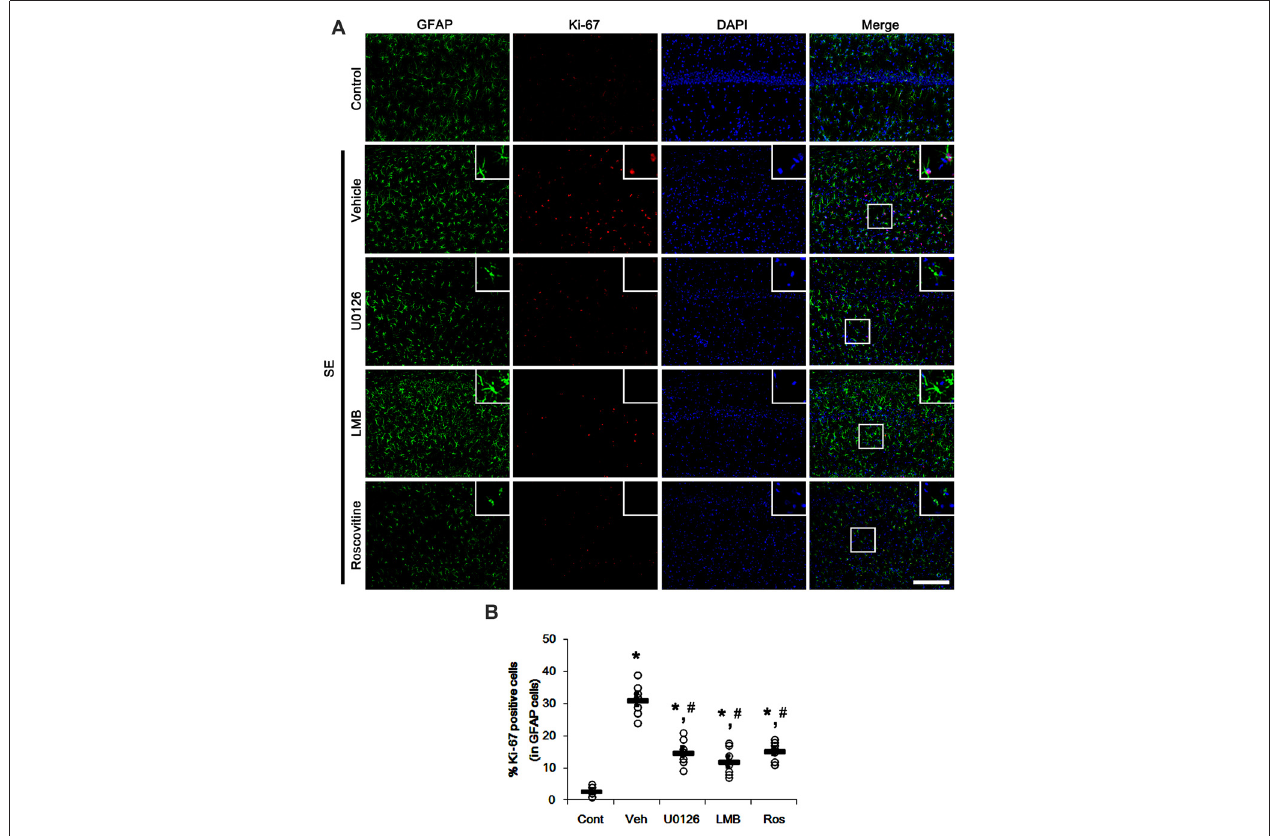
FIGURE 5 | Effects of U0126, LMB and roscovitine on Ki-67 expression in the CA1 region following SE. (A) Representative double immunofluorescent images for Ki-67 positive astrocytes. SE increases nuclear Ki-67 expression in astrocytes. As compared to vehicle, U0126, LMB and roscovitine reduce the number of Ki-67 positive astrocytes following SE. Insert images are high magnification of rectangles in merge panels. Bar = 100 and 25 (inserts) µ m. (B) Quantifications of the number of Ki-67 positive astrocytes. Open circles indicate each individual value. Horizontal bars indicate mean value. Error bars indicate SEM ( ∗ , # p < 0.05 vs. control and vehicle, respectively; n = 7,